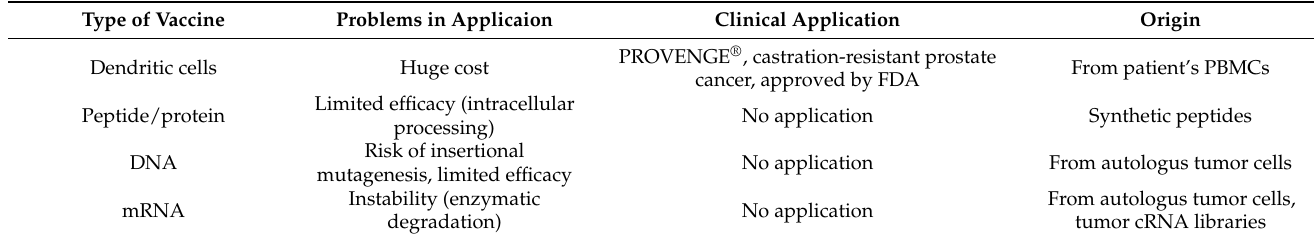
Table 2. Cancer vaccines investigated in preclinical and clinical